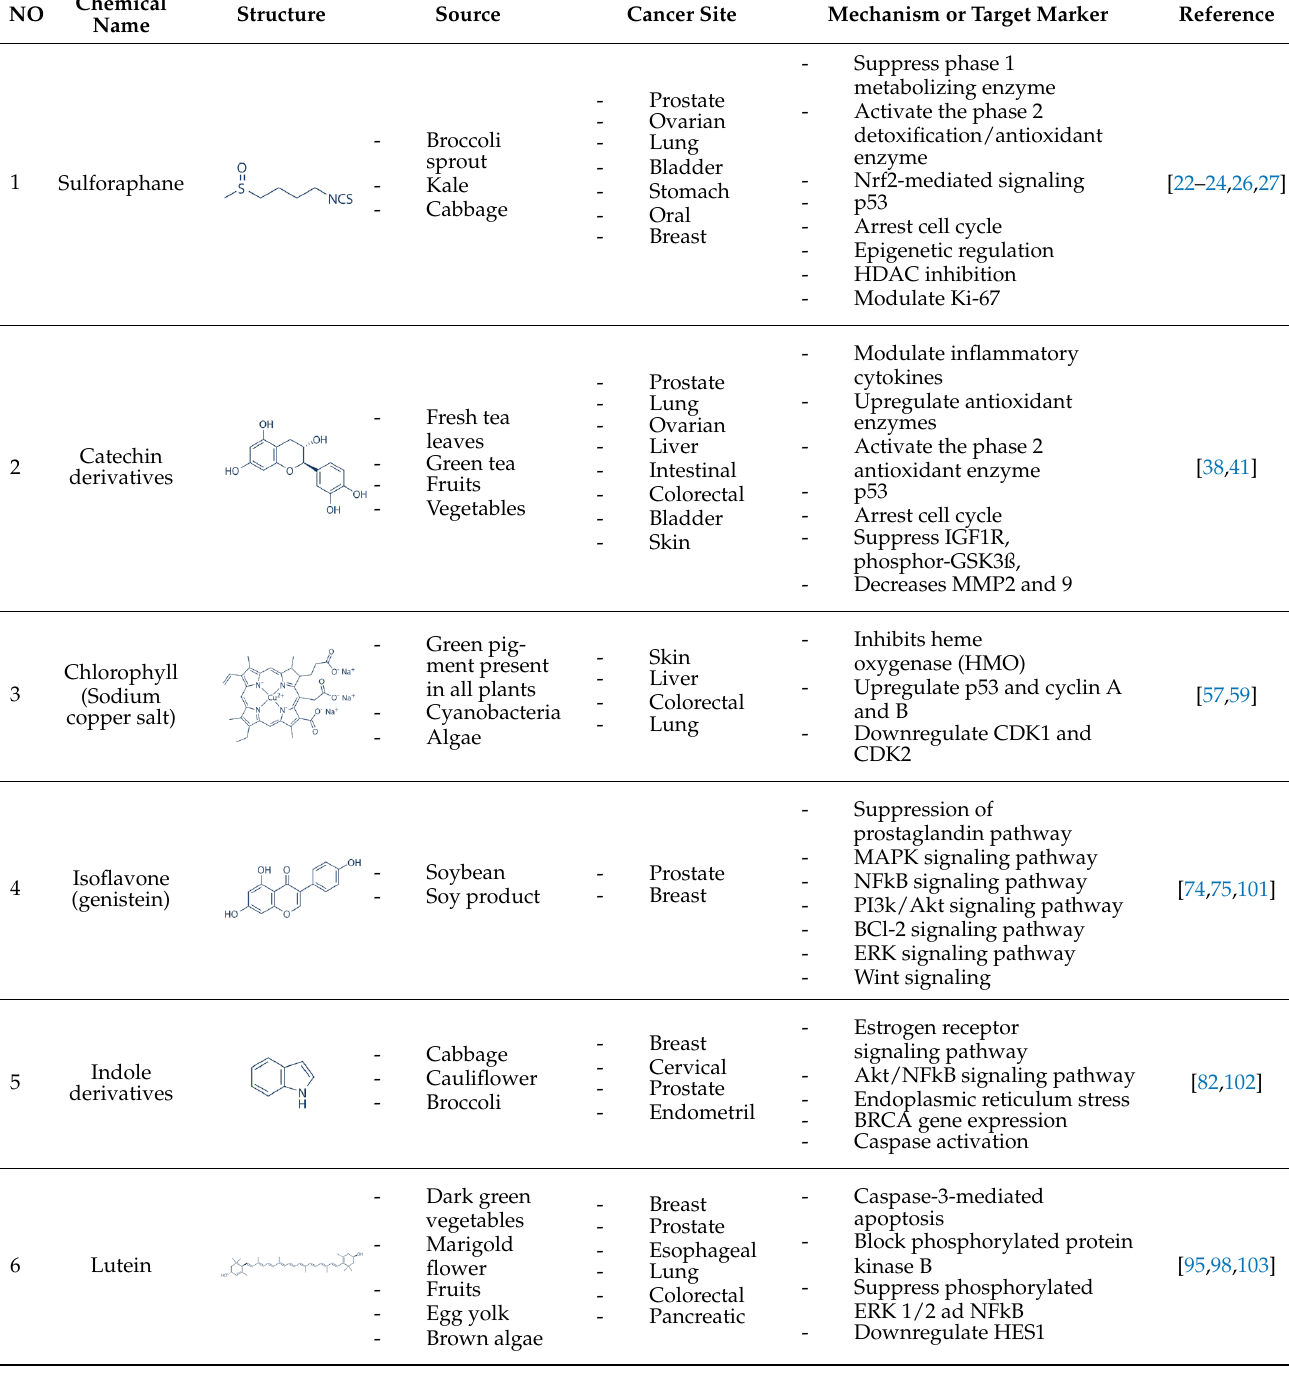
Table 1. Anti-cancer activities of green-colored food-derived bioactive compounds and their mechanisms.